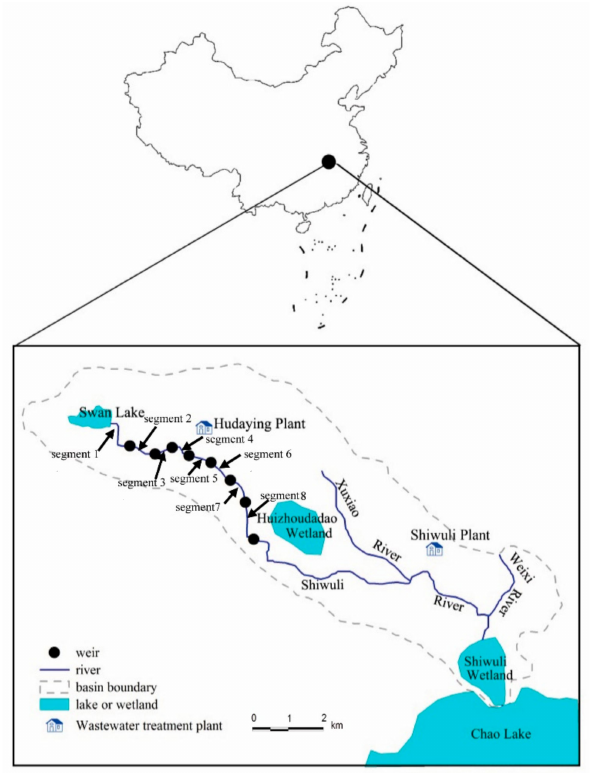
Figure 1. Location of the Shiwuli River and its